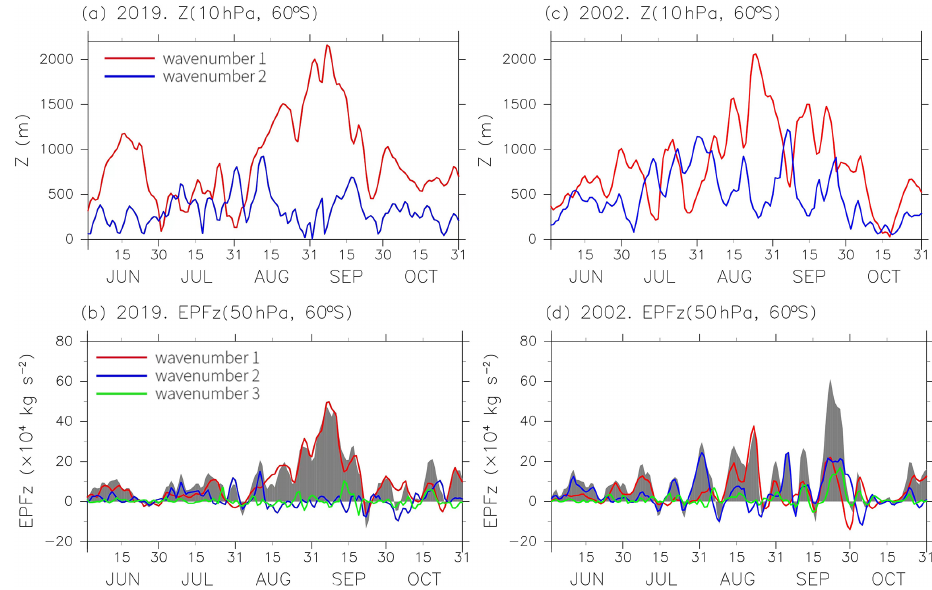
Figure 4. Time series of planetary wave amplitudes (m) at 10hPa and 60 ◦ S (a, c) and the vertical component of the E–P flux ( × 10 4 kgs − 2 ) at 60 ◦ S and 50hPa (b, d) from 1 June to 31 October for 2019 (a, b) and 2002 (c, d) . The red, blue, and green lines denote the zonal wavenumbers 1, 2, and 3, respectively. In the bottom panels, gray shading shows the vertical component of the E–P flux of all